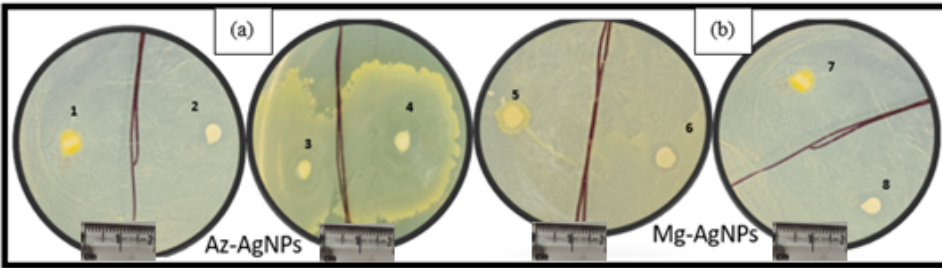
Figure 13. In vitro zone of inhibition effect (mm) of ( a ) A-AgNPs and ( b ) M-AgNPs against X. Oryzae bacterial growth on PDA medium after incubation at 27 ± 1 °C.